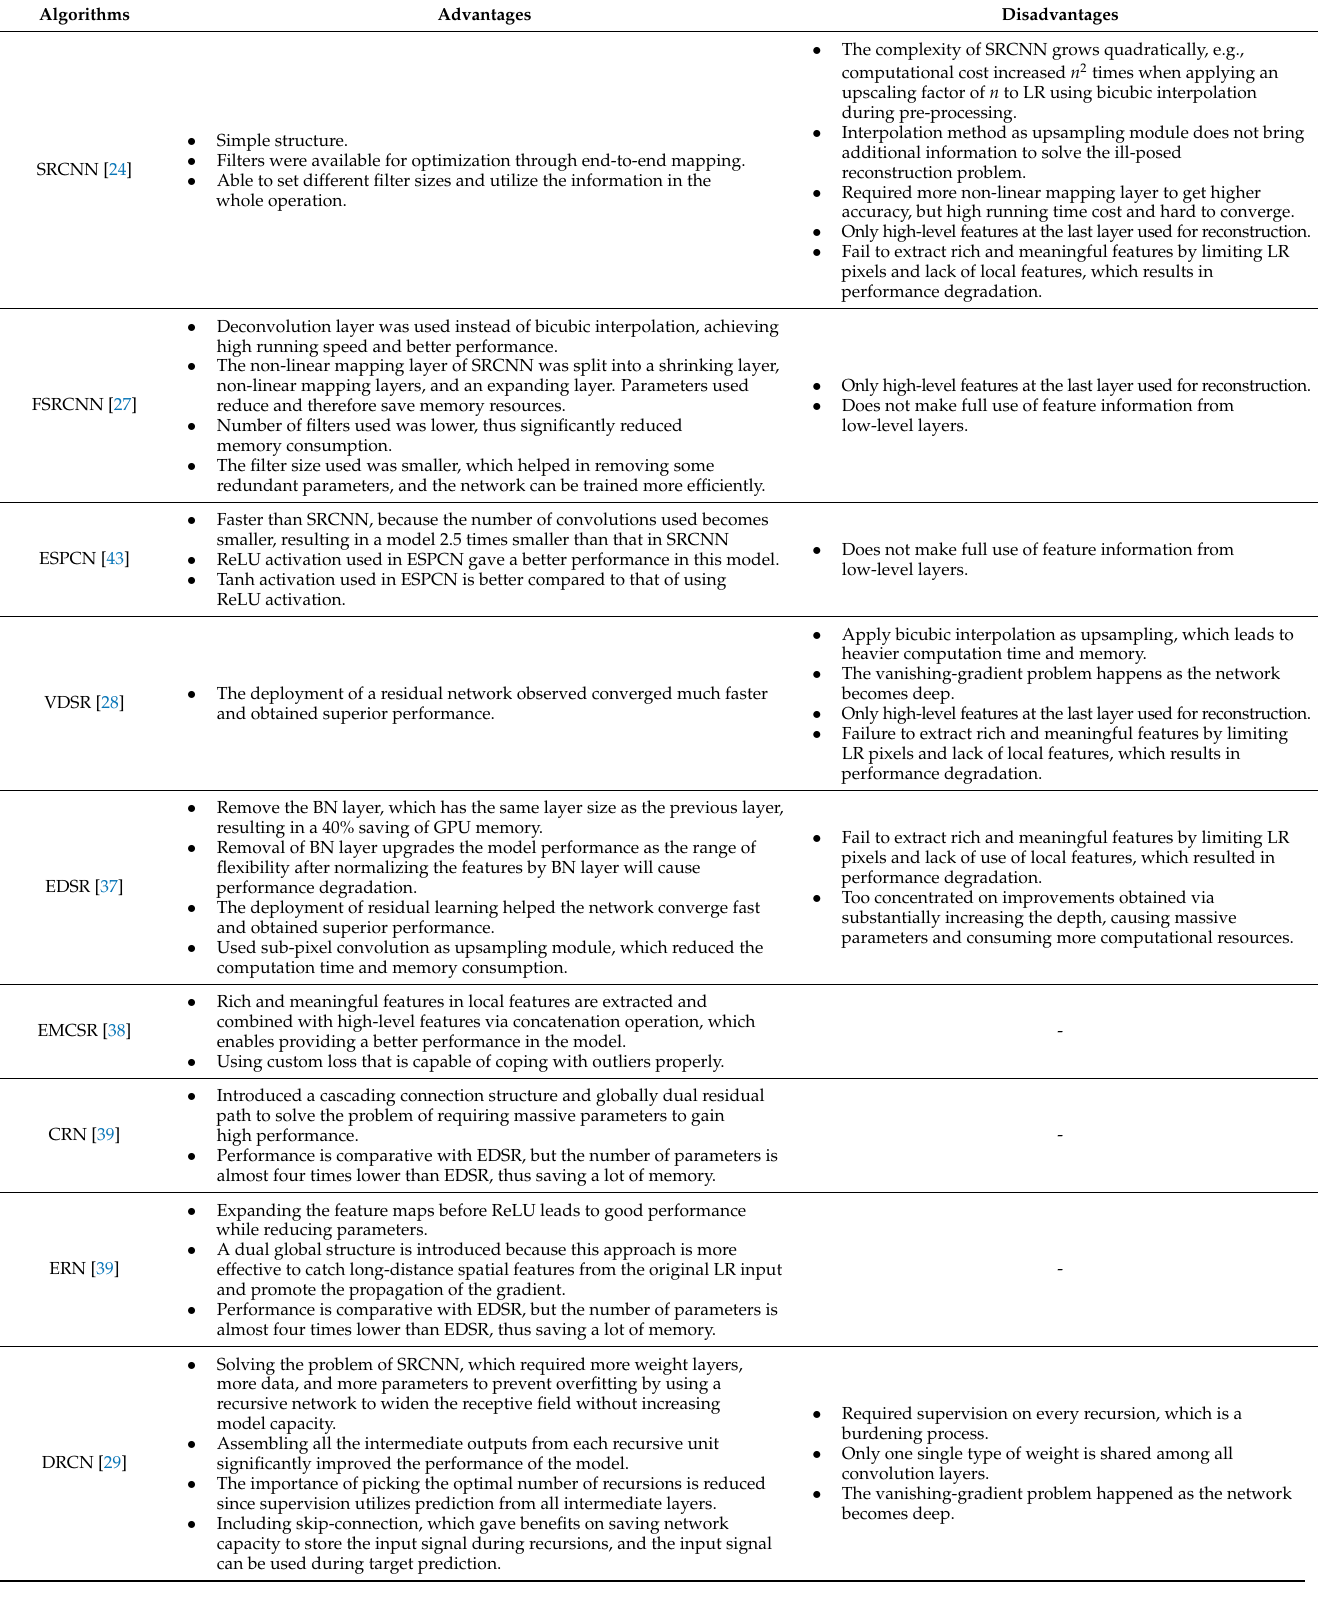
Table 6. Advantage and disadvantage of each